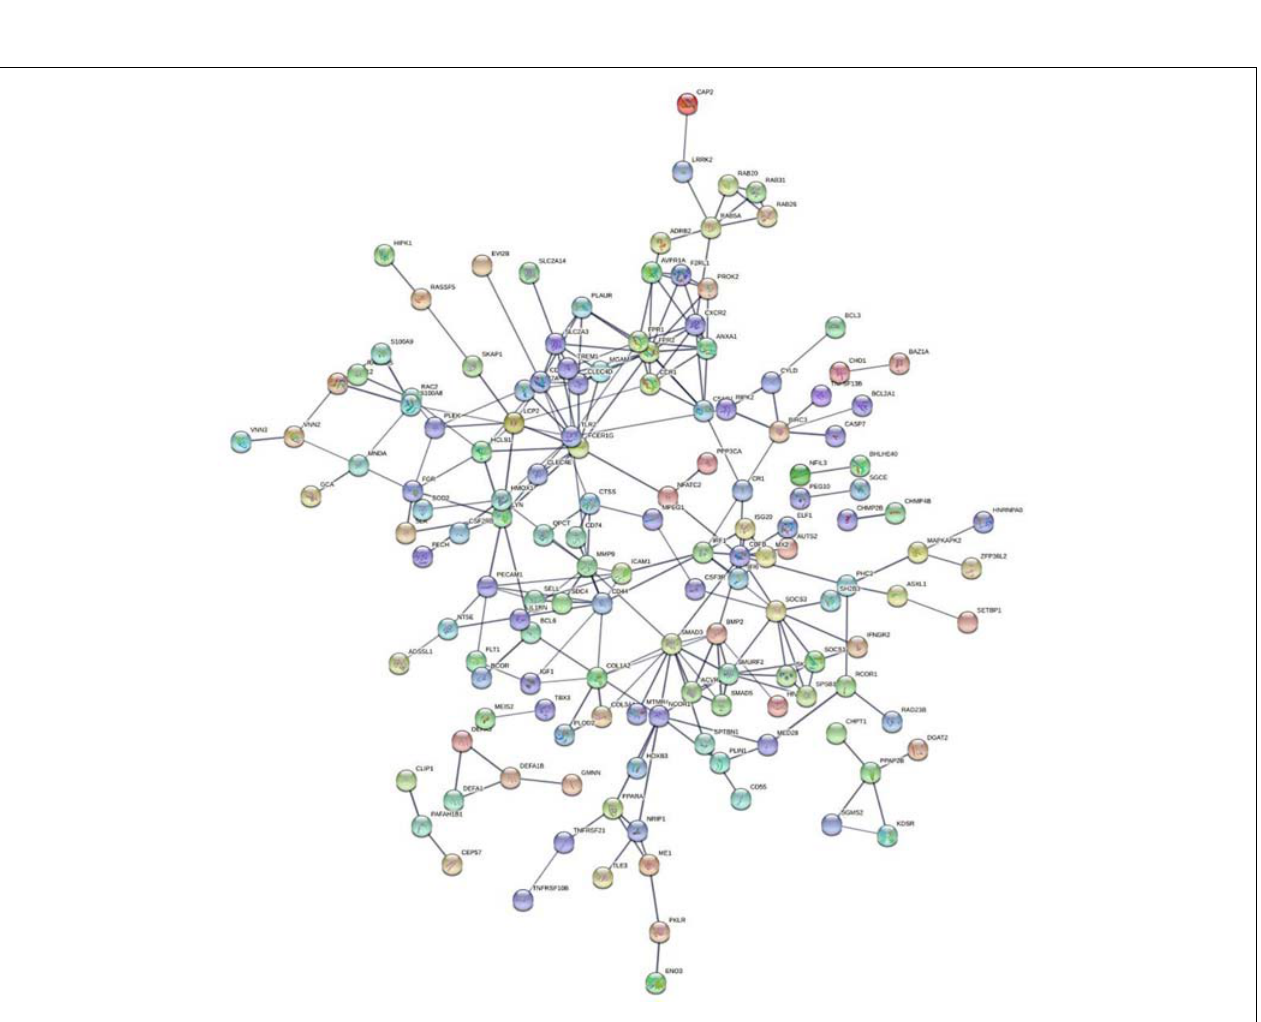
FIGURE 3 | Protein-protein